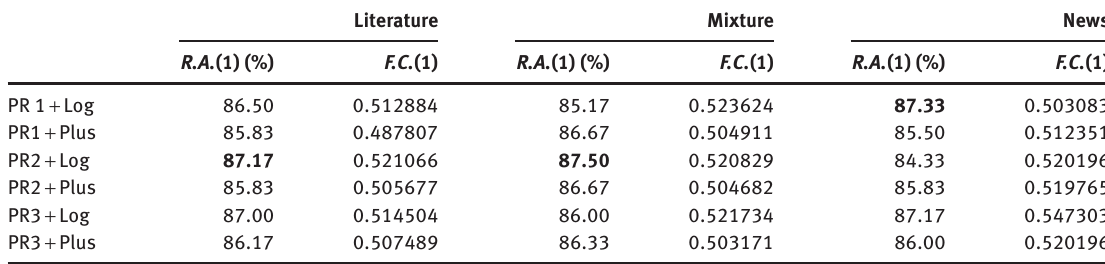
Table 2: Results of Genuine CLSI.